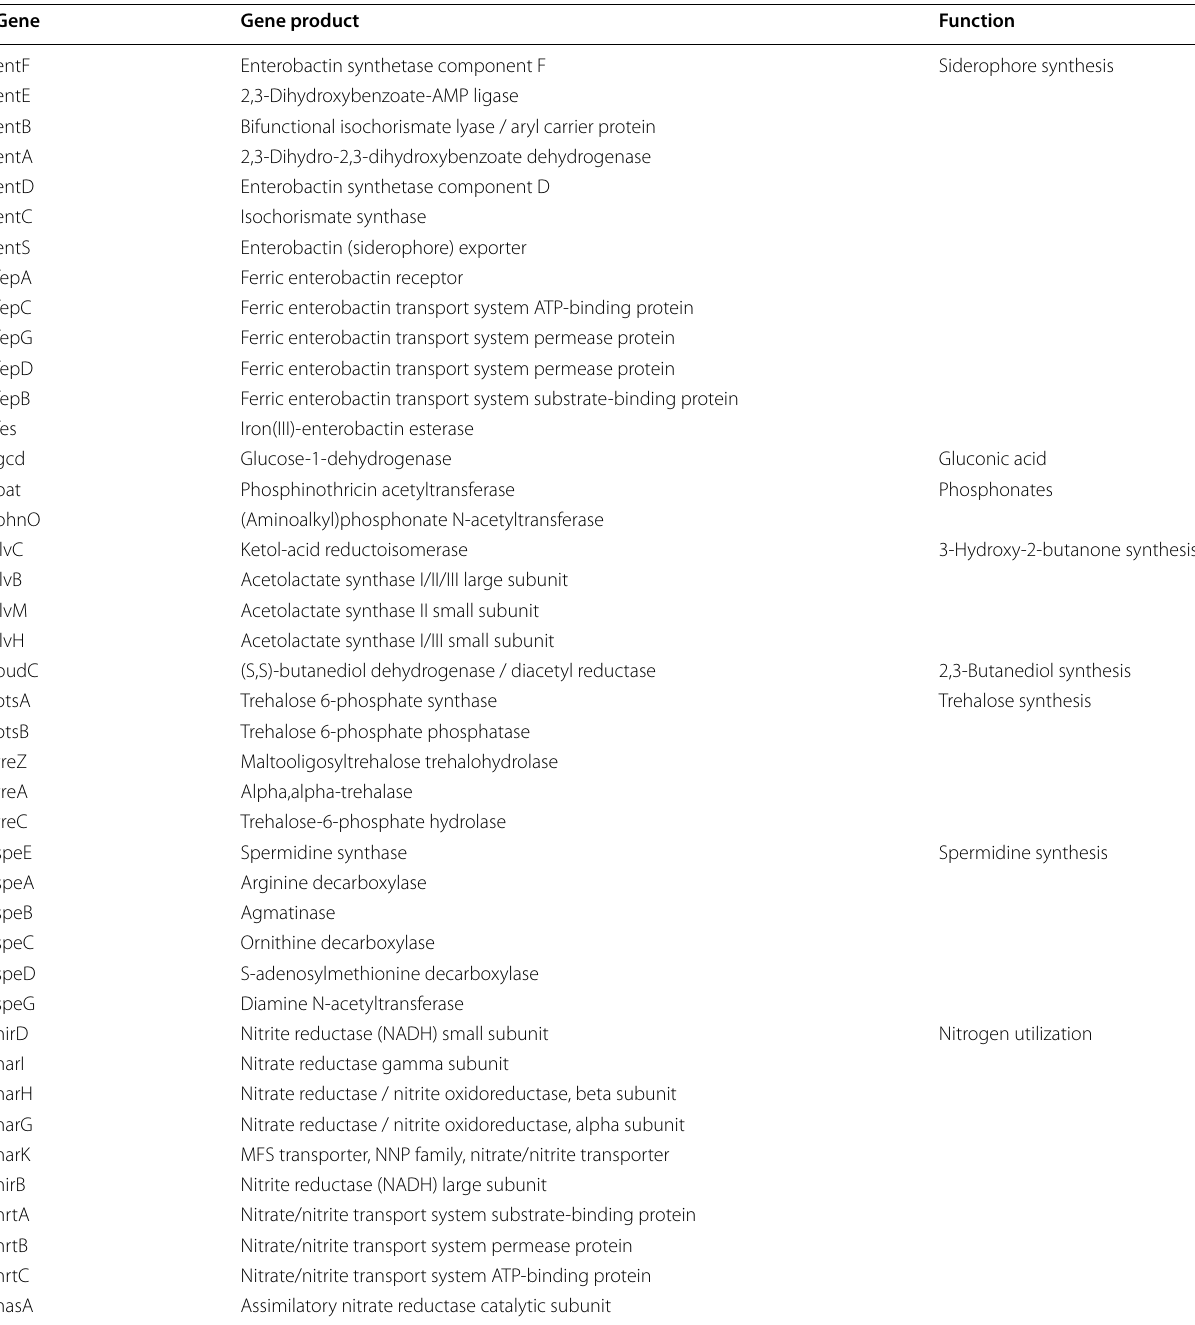
Table 5 Genes related to plant growth promotion in the mutant strain YSD YN2 genome Gene Gene